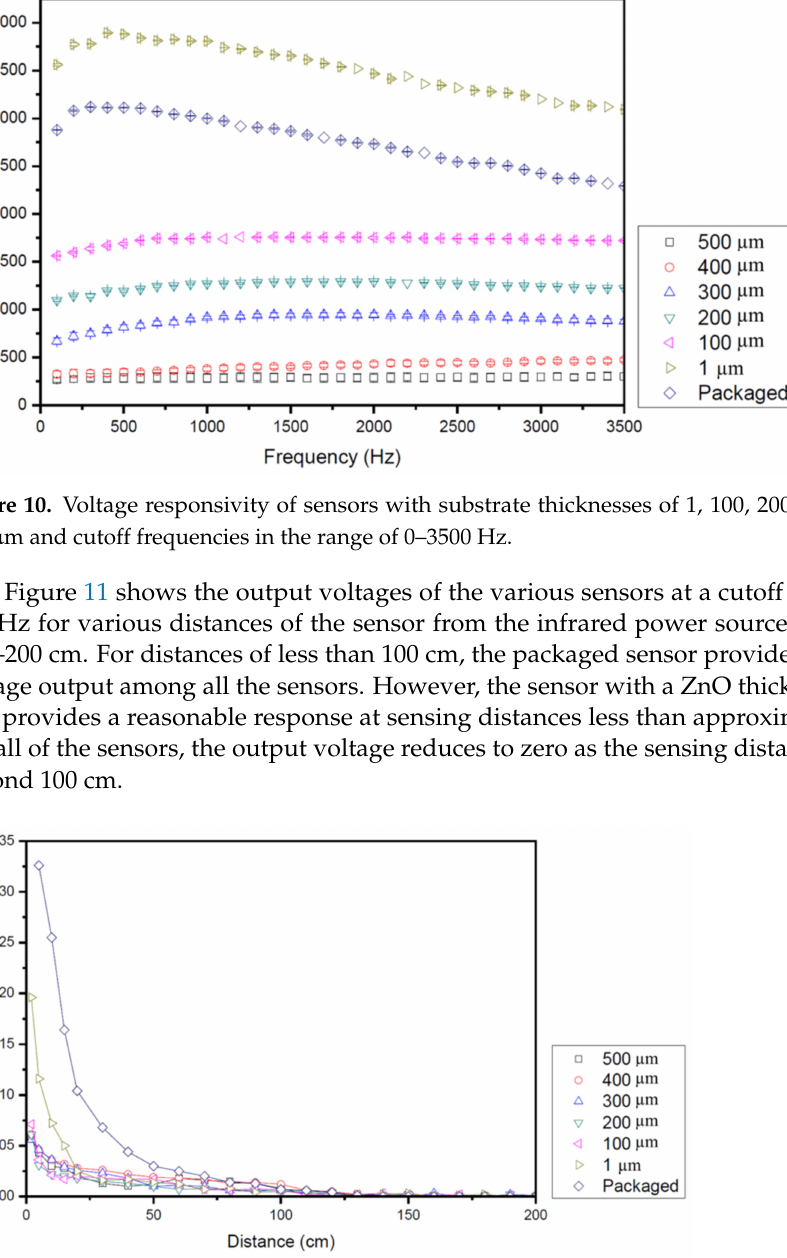
Figure 11. Voltage response of different sensors located at distances of 0–200 cm from infrared power source. Note that the cutoff frequency is equal to 400 Hz in every